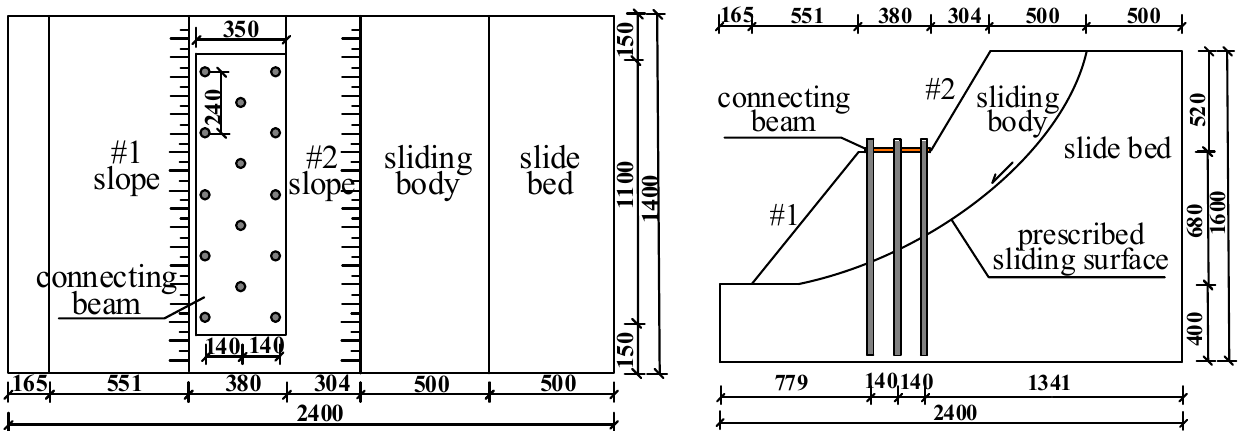
Figure 2 . Plan and section view of the landslide model (unit: mm). Figure 2. Plan and section view of the landslide model (unit: mm). Table 1. The similarity ratios of the test